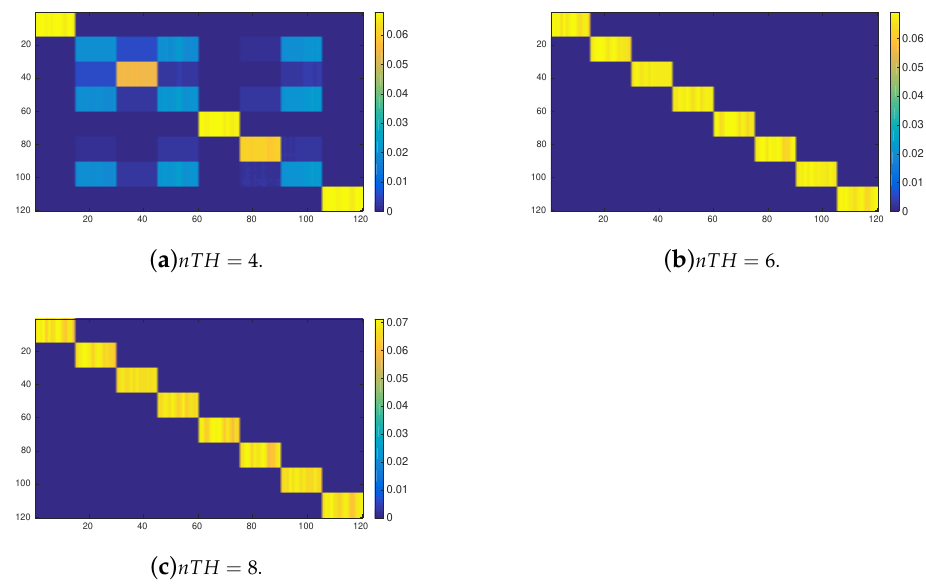
Figure 11. Probabilistic transition matrix, induced by the YPRF, powered after 500 iterations ( P 500 ) for the 120 tasks arranged into 8 clusters and different values of nTH